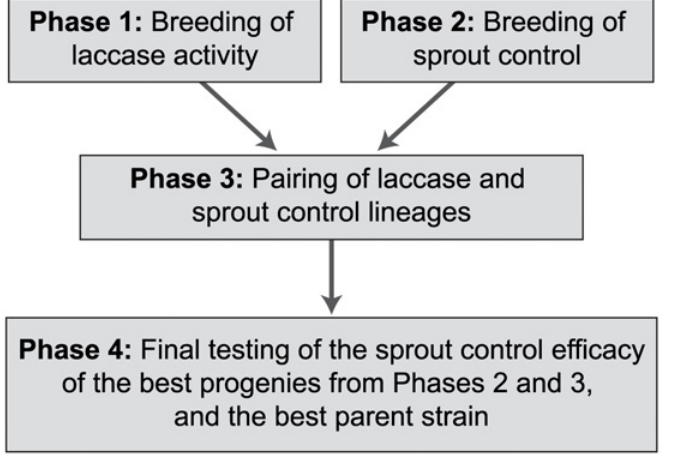
Fig 1. The Breeding Process of the